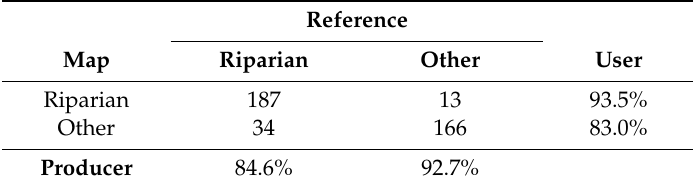
Table 5. Accuracy assessment for riparian map of Nevada